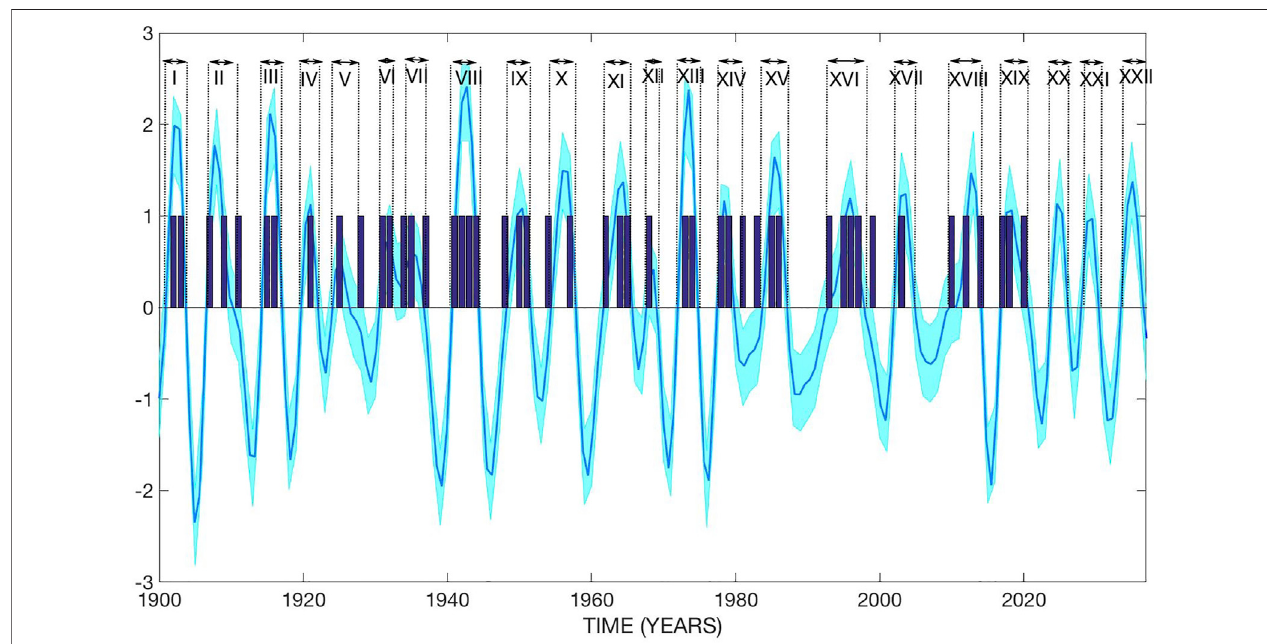
FIGURE 6 | Probabilistic earthquake prediction( M ≥ 7) for southwestern Mexico. Bayesian inference of LS-SVM model (blue line and shade) compared with the historical earthquakes clustered in nineteen clusters (I-XIX) and shown with vertical blue bars from 1900 to 2021. In addition, the probabilistic earthquake prediction is shown for the following three periods (clusters XX-XXII). The blue shaded area represents the 95% con fi dence intervals of the Bayesian model.